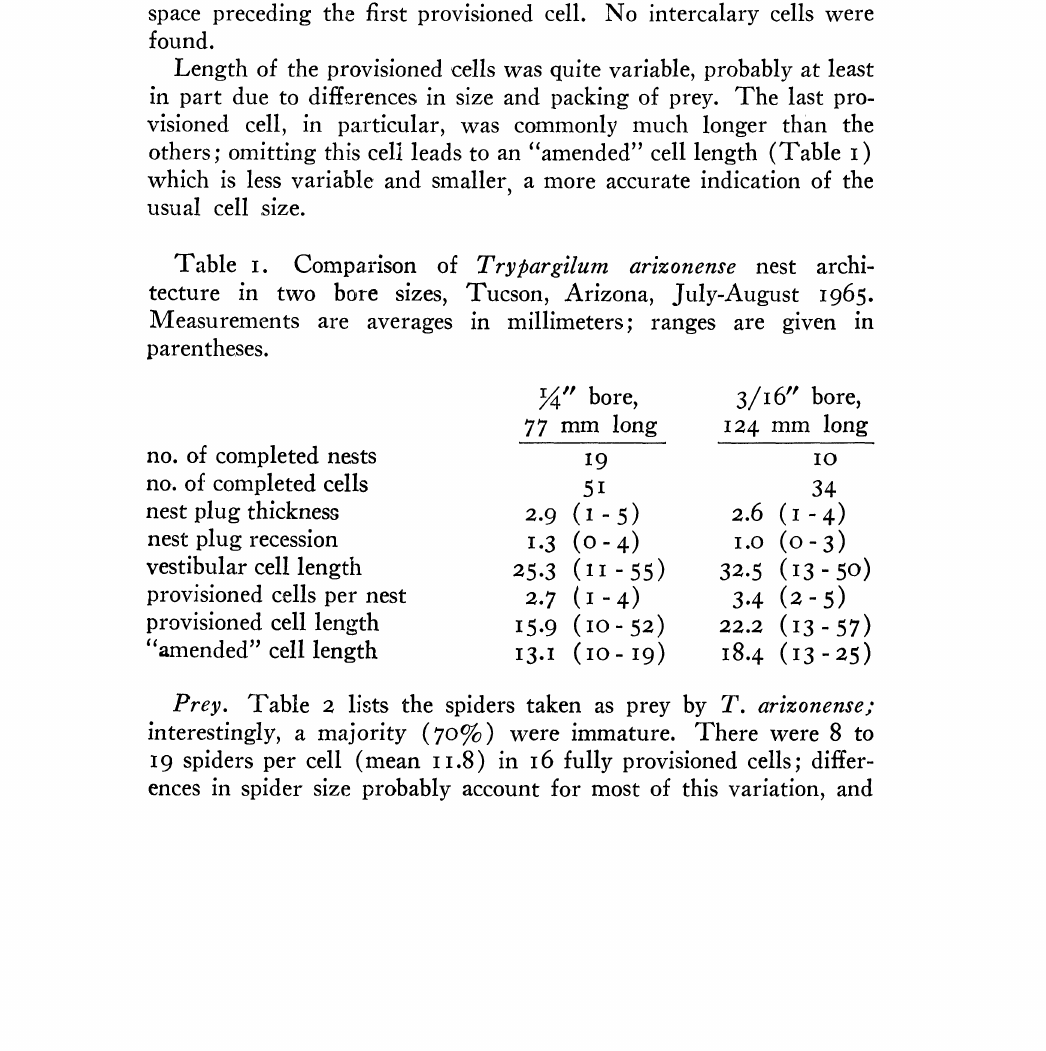
Comparison of Tryargilum arizonense nest archi- tecture in two bore sizes, Tucson, Arizona, July-August I965. Measurements are averages in millimeters; ranges are given in